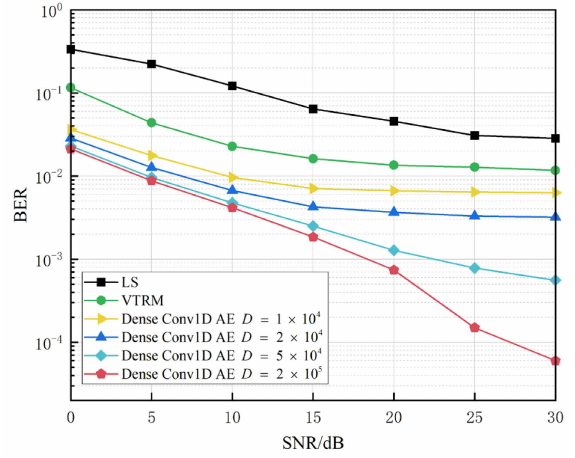
Figure 7. Effect of training data size on BER performance.